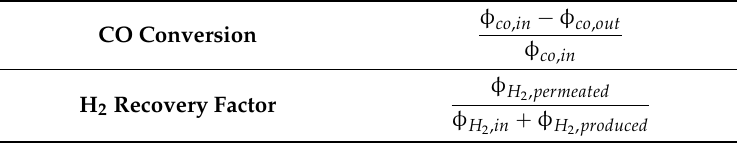
Table 3. Parameters that were used to quantify the reactor